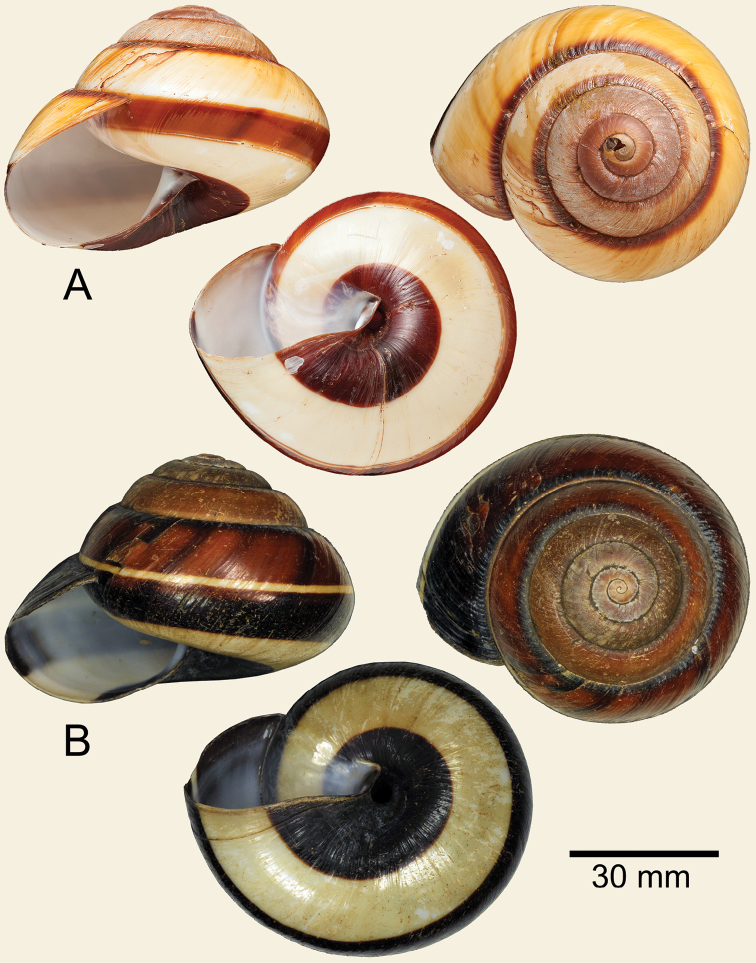
Shells of Bertia
cambojiensisA lectotype NHMUK 20130220 and B specimen NHMUK 20130833.